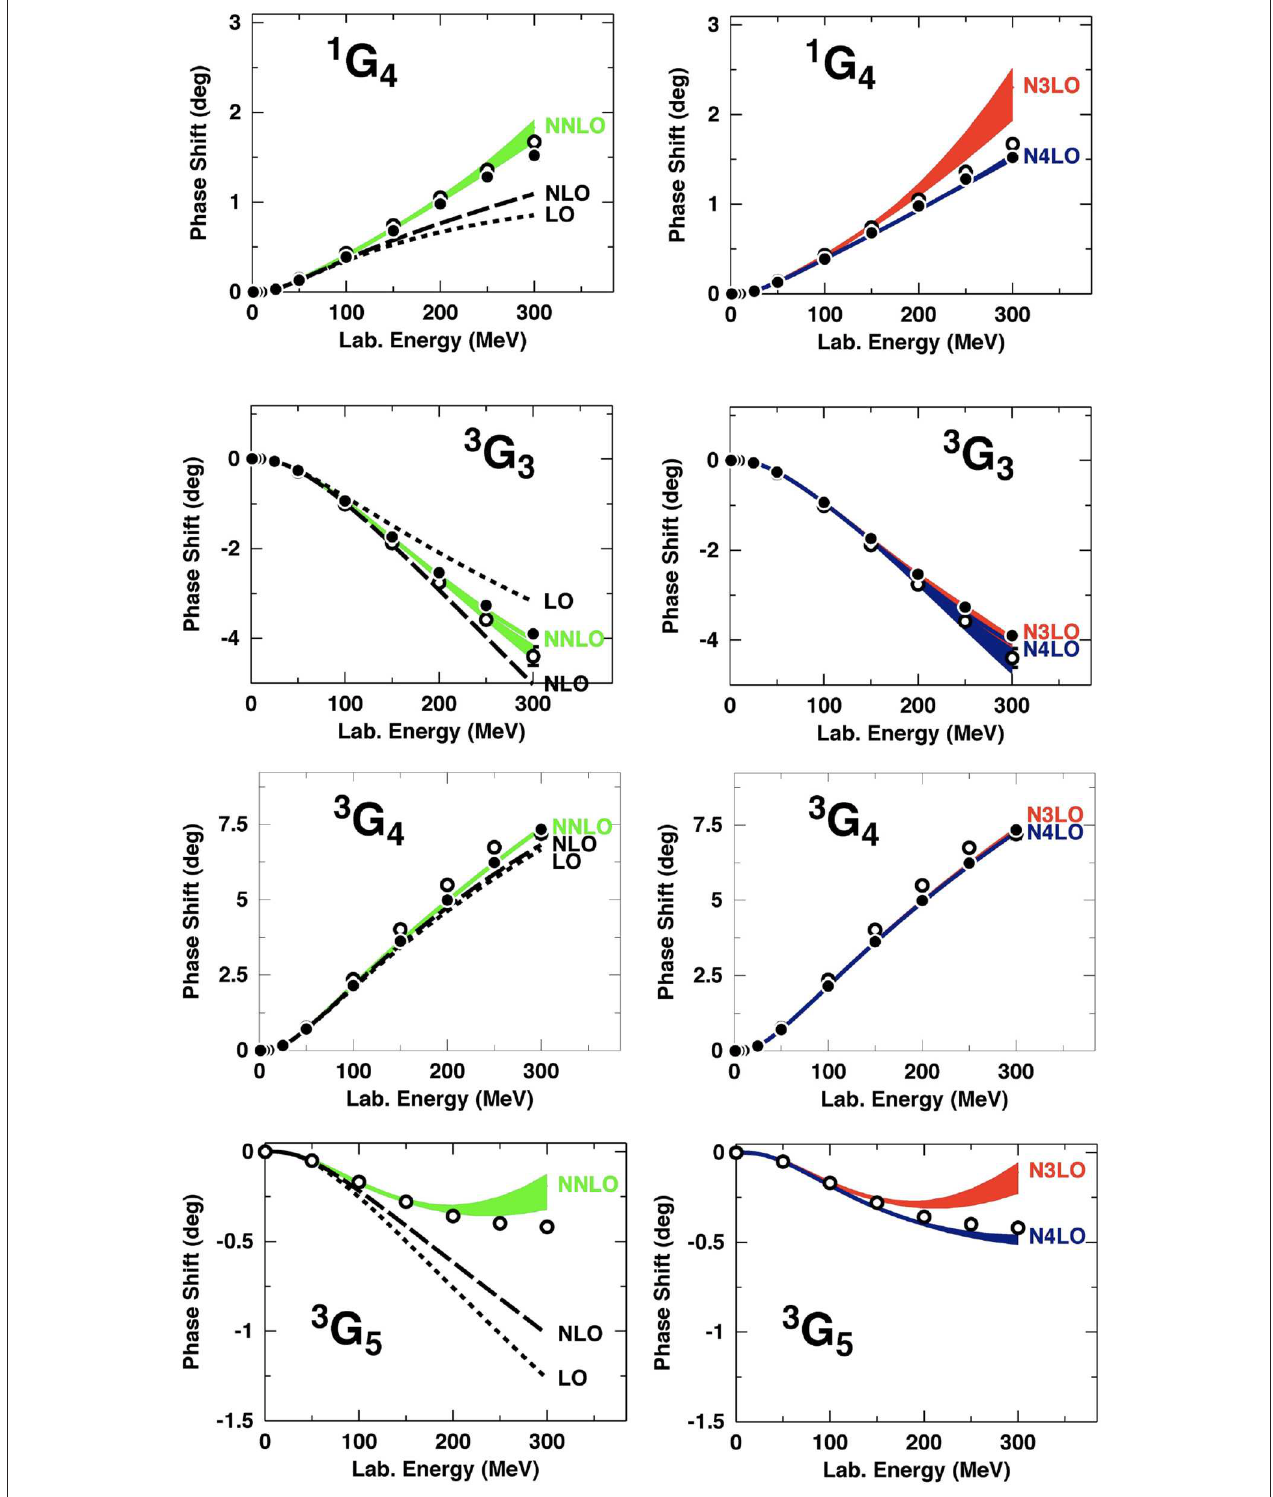
FIGURE 11 | Same as Figure 10 , but for G waves. Reprinted figure with permission from Entem et al. [46], copyright (2015) by the American Physical Society.